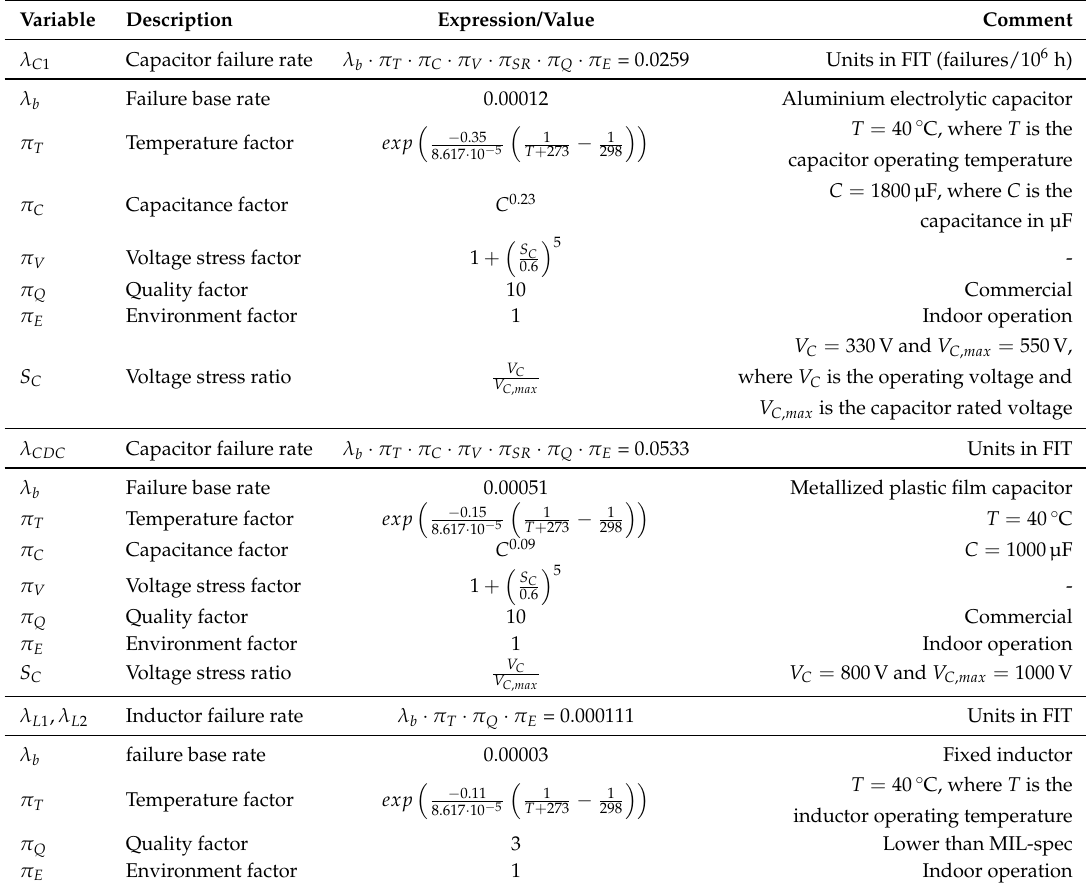
Table A1. Adjustment factors for component failure rate calculation